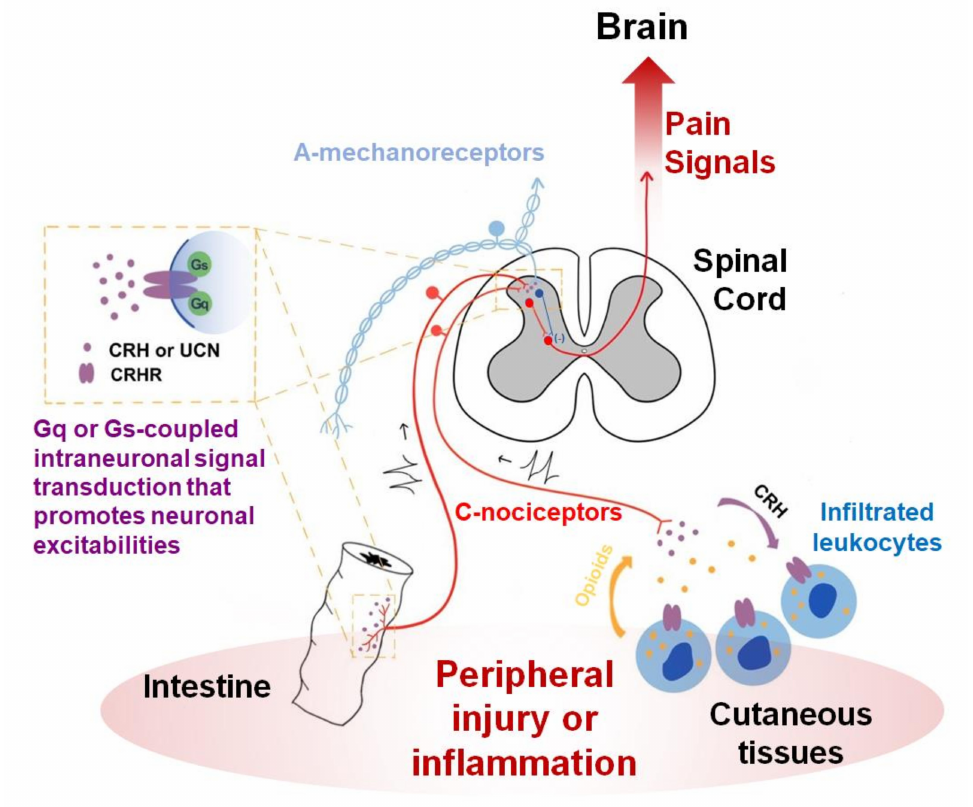
Figure 1. A conceptual diagram depicting the role of CRH and its receptors in the peripheral nociceptor-based circuit. Injured or inflamed intestines may locally secrete CRH, stimulating CRHRs in the peripheral termini of nociceptors, which can promote their excitations via Gs- or Gq-protein α subunits-mediated intracellular signaling. By contrast, CRH antidromically released from those termini can occasionally activate CRHRs in infiltrated immune cells, dampening nociceptor signals by providing endogenous opioids. CRH released from the central termini of nociceptors may possibly activate interneuronal CRHRs in the superficial laminae in the spinal cord and then pain transmission can be attenuated. Spinal deep laminae are also known to express CRHRs but the cellular components that stimulate those by secreting ligands remains to be